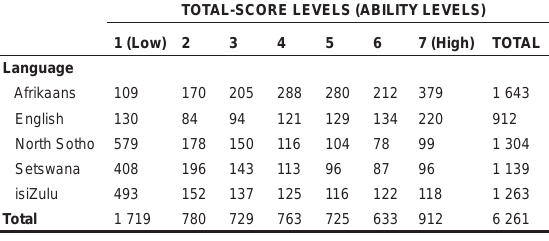
Scree plot for the factor-analytical procedure of Schepers (1992) in respect of the